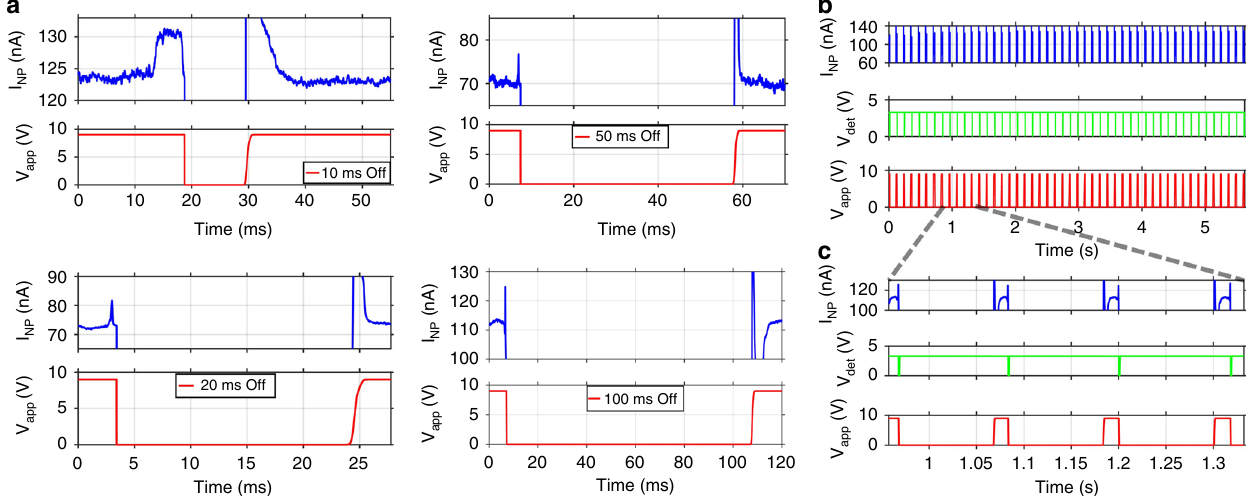
Fig. 3 Automated delivery of successive 70S ribosomes. a Automatic re-application of voltage across the pore after user-de fi ned time delays (here: 10, 20, 50, and 100 ms) during which the pore is closed. Note that the vertical axis limit for I NP has been chosen for best visibility of the molecular signatures. The saturation limit of the setup is 200 nA. b Demonstration of automated delivery of 48 ribosomes (~513/min) into the micro fl uidic channel where the voltage is re-applied 100 ms after each translocation; top: nanopore current, center: translocation detection pulses, bottom: voltage applied across pore; c zoomed- in view of panel b revealing translocation events and how pore is switched off for 100 ms after a translocation has been detected